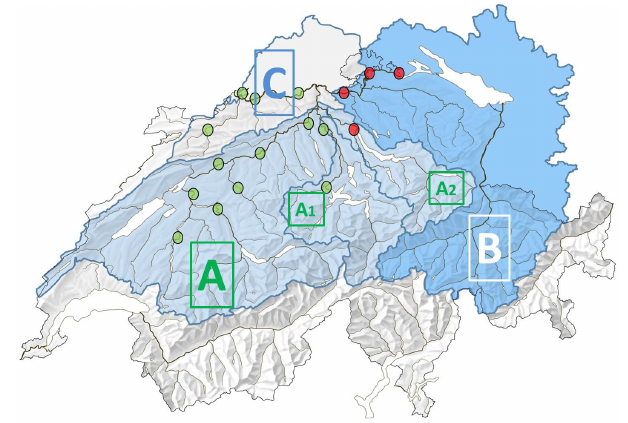
Figure 21. Contribution (green dots) and non-contribution (red dots) of rivers to particular pre-instrumental minor flood events. A: Aare catchment; A1: Reuss catchment; A2: Limmat catchment; B: High Rhine catchment; C: Jura